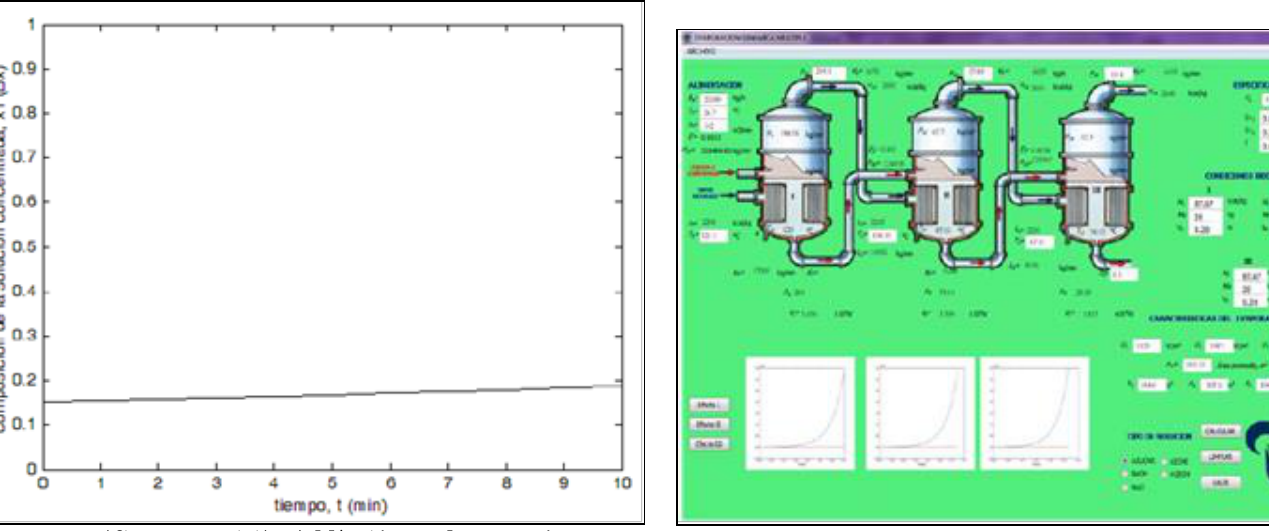
Figura 6: Interfaz gráfica para la simulación de un sistema de evaporación de triple